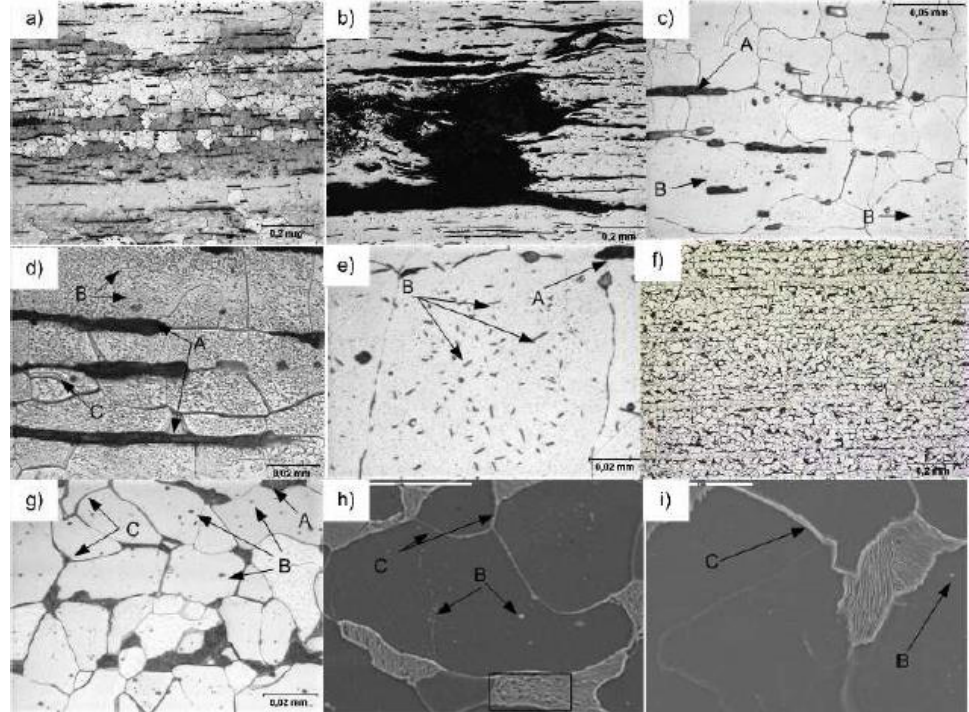
Figure 1. A typical microstructure of the long term-operated late 19th and early 20th century steels (described in the text). ( a ) typical microstructure of puddle iron, ( b ) enlarged non-metallic inclusion in puddle iron, ( c ) magnified microstructure of puddle iron, ( d ) magnified microstructure of puddle iron with microstructural degradation symptoms, ( e ) enlarged ferrite grain with degradation symptoms–puddle iron, ( f ) typical microstructure of early 20th century mild steel, ( g ) enlarged ferrite-pearlite microstructure of early 20th century mild steel, ( h ) SEM (Scanning Electron Microscope) image of early 20th century mild steel misstructure with small precipitations inside ferrite grains and degraded pearlites areas, ( i ) SEM (Scanning Electron Microscope) image of early 20th century mild steel misstructure without degradation